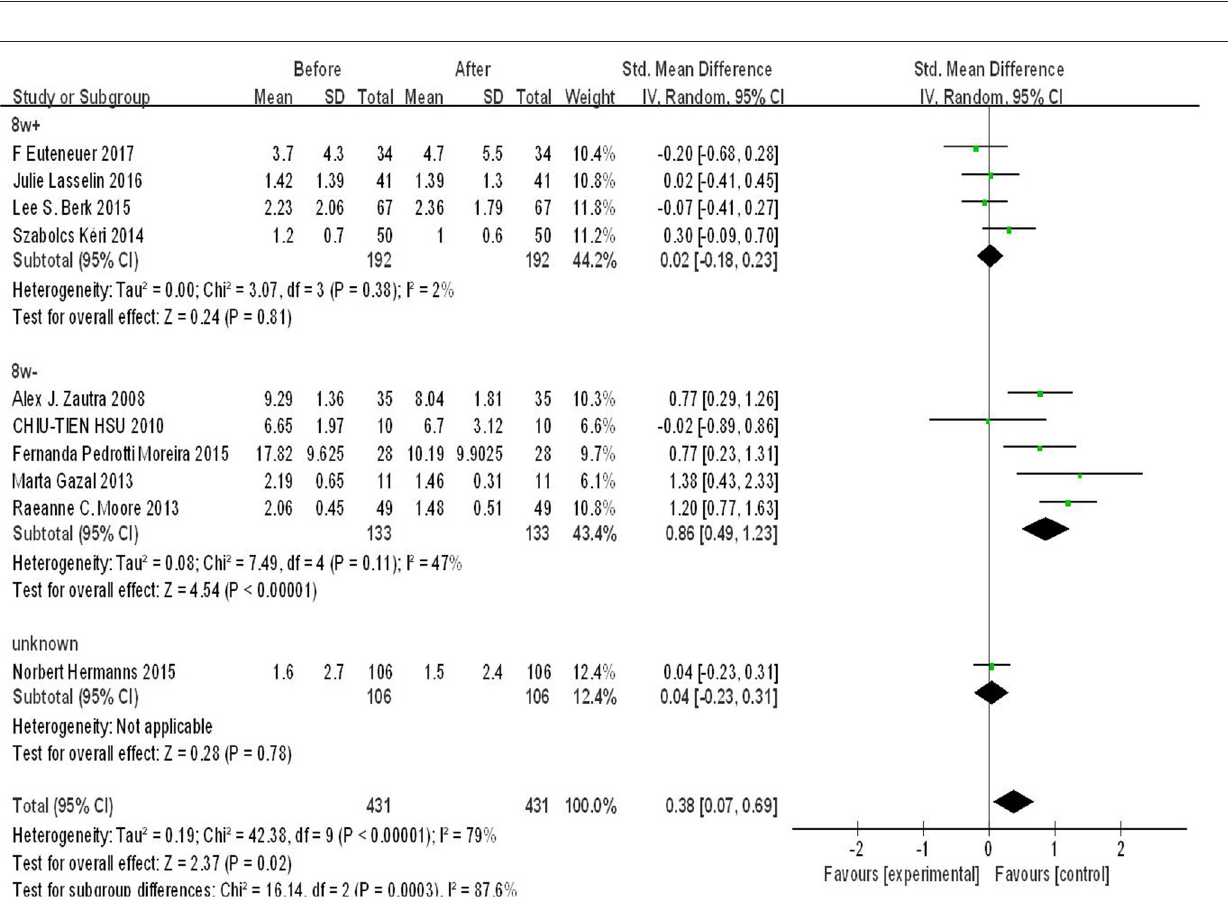
FIGURE 2 | Forest plot for change in IL-6 before and after CBT.